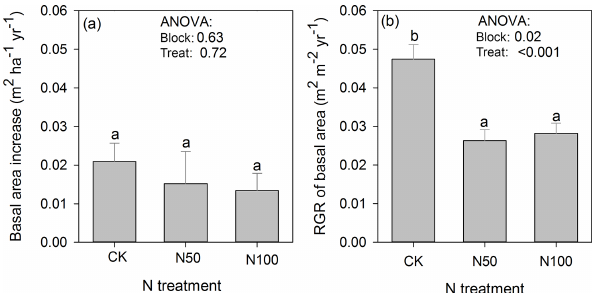
Figure 4. Effects of N fertilization on the growth of saplings (mean ± SE). (a) Absolute basal area increase and (b) the rel- ative growth rate of basal area. Numbers in these figures indi- cate the results of ANOVA. The N treatment on the x axis repre- sents three levels of N fertilization: CK (0kg N ha − 1 yr − 1 ) , N50 (50kg Nha − 1 yr − 1 ) and N100 (100kg Nha − 1 yr − 1 )